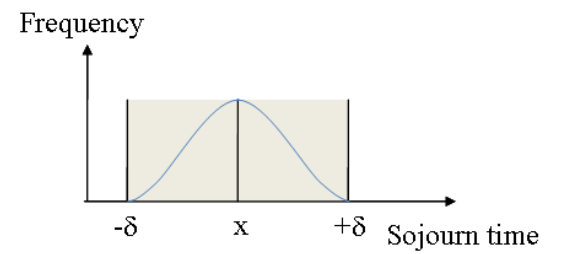
Figure 4. Graphical illustration of the scoring